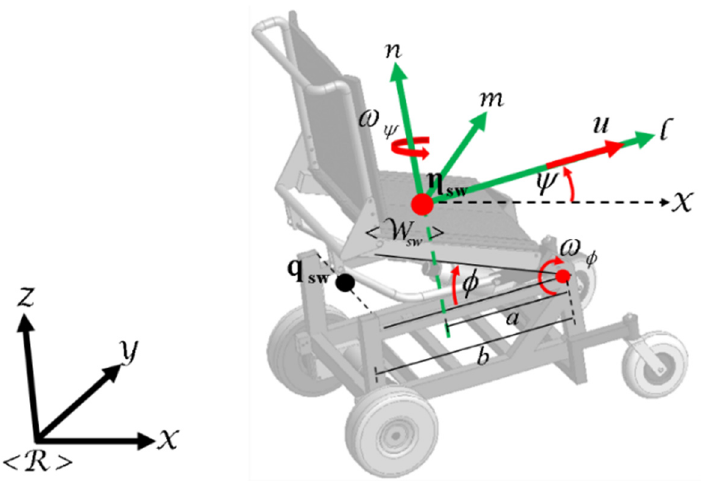
Figure 4. Robotic standing wheelchair.